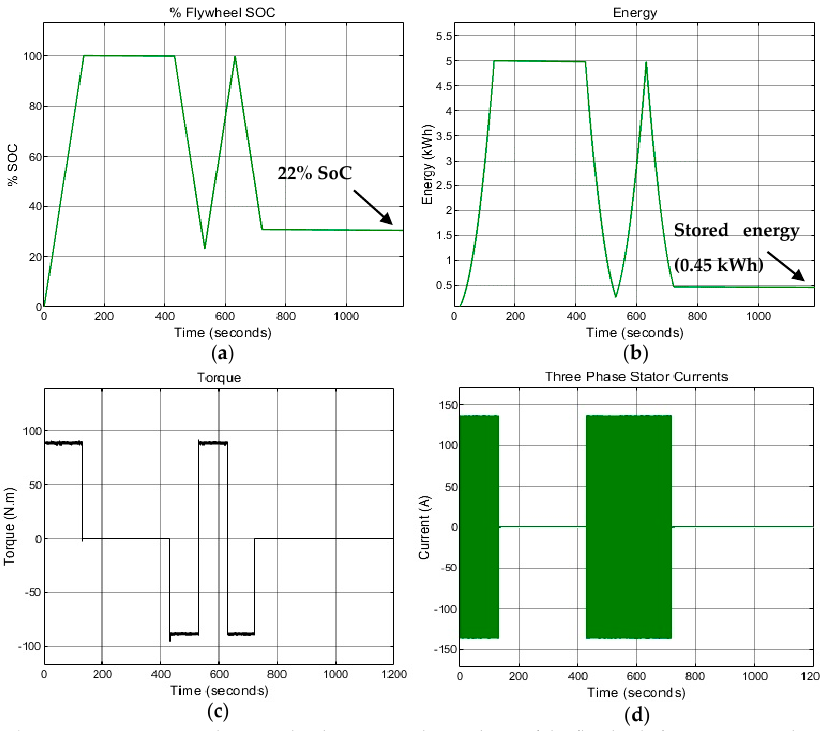
Figure 8. SCIM-FESS acceleration-deceleration mode: ( a ) %SoC of the flywheel; ( b ) Energy stored; ( c ) Mechanical torque; ( d ) Three phase stator currents. Appl. Sci. 2019 , 9 , x